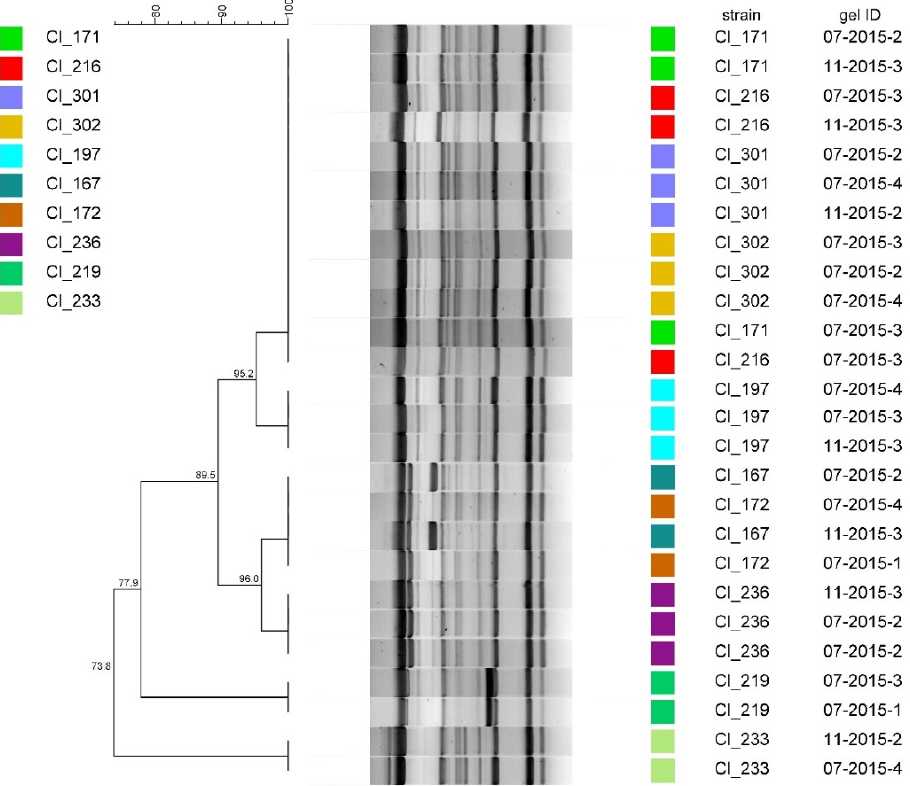
Figure 3. Dendrogram obtained from repeated repetitive element palindromic PCR (rep-PCR) (GTG) 5 fingerprinting of 10 C. tyrobutyricum strains. The dendrogram was constructed using the unweighted pair group method with arithmetic mean (UPGMA) with similarity levels expressed as percentage values of Dice’s correlation coefficient. The column ‘gelID’ identifies the gel by the month and year of analysis and the gel number.